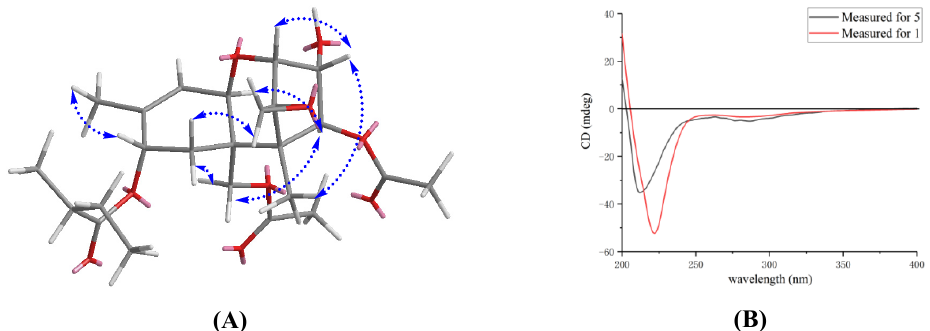
Figure 3. Key NOESY correlations (blue double arrow) of compound 1 ( A ); experimental ECD spectra of 1 (red line) and 5 (black line) in MeOH ( B ).